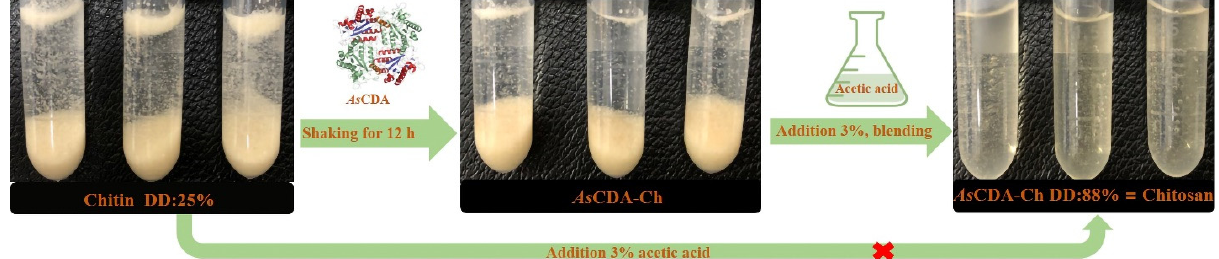
Figure 7. Simplified diagram of As CDA to catalyze crystalline chitin deacetylation to prepare chi ‐ tosan.